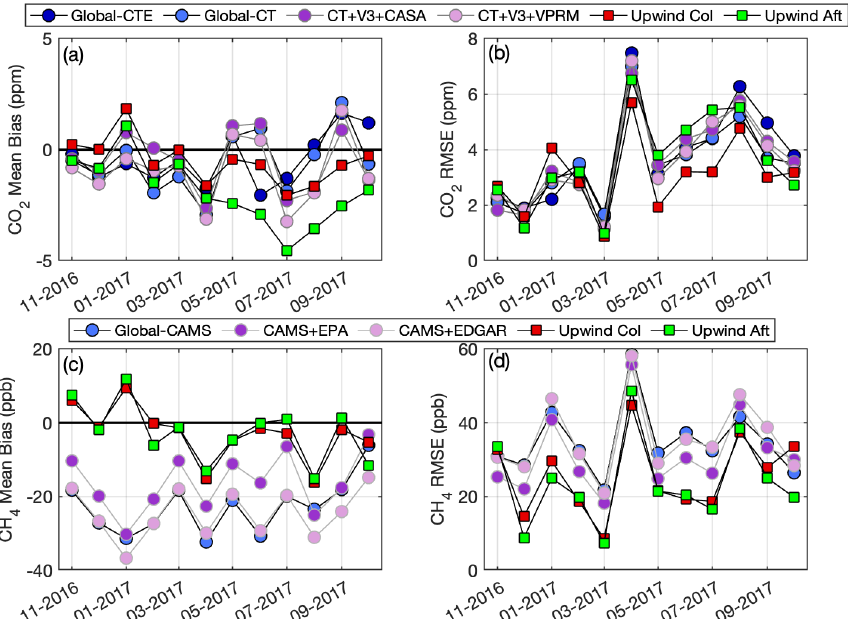
Figure 6. Average monthly bias (model–observation) (a, c) and RMSE (b, d) for different backgrounds over all six urban sites during periods of low influence from within the domain of interest. (a, b) are for CO 2 ; (c, d) are for CH 4 . All models use the same fluxes inside the urban domain; only the background varies, as indicated in the legends above each set of panels, with abbreviations from Table